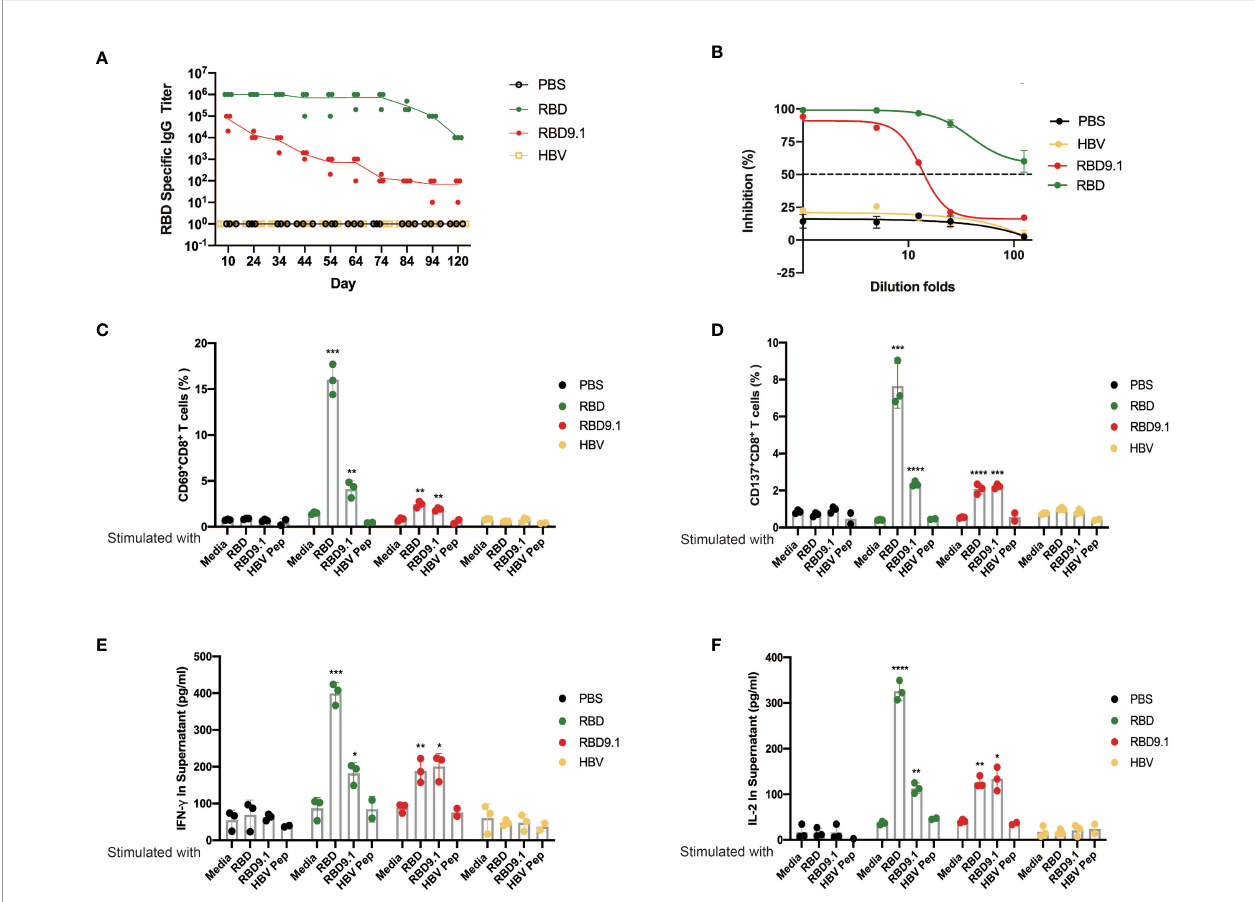
FIGURE 6 | (A) RBD9.1 antigenic peptide induced long-term protection. Receptor-binding domain (RBD) – binding immunoglobulin G (IgG) antibody ELISA titers by mouse sera taken 10, 24, 34, 44, 54, 64, 74, 84, 94, and 120 days following the last immunization. (B) RBD-blocking assay for severe acute respiratory syndrome coronavirus 2 (SARS-CoV-2) (wild-type) by mouse sera taken 64 days following the last dose of RBD or RBD9.1. (C) The expressions of CD69 and CD137 (D) (gated on CD8 + T cells of immune mice) were detected by fl ow cytometry after 10 m g/ml RBD, RBD9.1, or HBV peptide stimulation for 24 h; normal medium was used as negative control. (E) The quantities of interleukin (IL)-2 and interferon (IFN)- g (F) in the supernatant were detected by ELISA after 10 m g/ml of RBD, RBD9.1, or HBV peptide stimulation for 48 h; normal medium or HBV peptide was used as corresponding negative control. * P < 0.05, ** P < 0.01, *** P < 0.001, **** P <